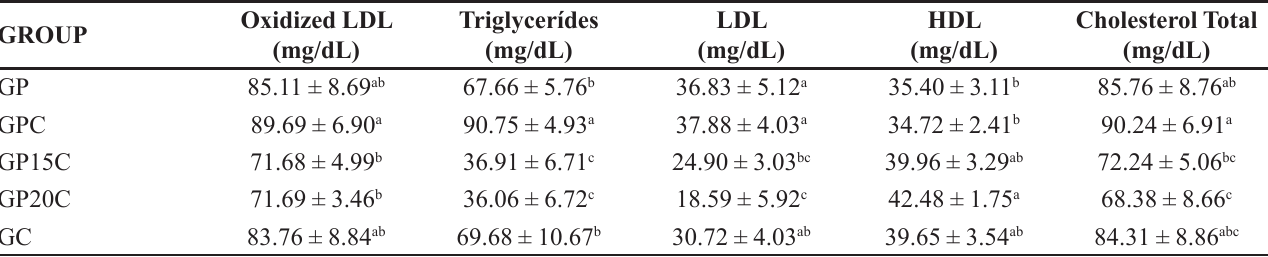
GP - diet with bread; GPC - diet with bread and cholesterol; GP15C - diet with 15% quinoa bread and cholesterol; GP20C - diet with 20% quinoa bread and cholesterol; GC - diet with cholesterol. Values in the same column with different letters indicate a statistically significant difference between the means by the Tukey test (p ≤ 0.05).